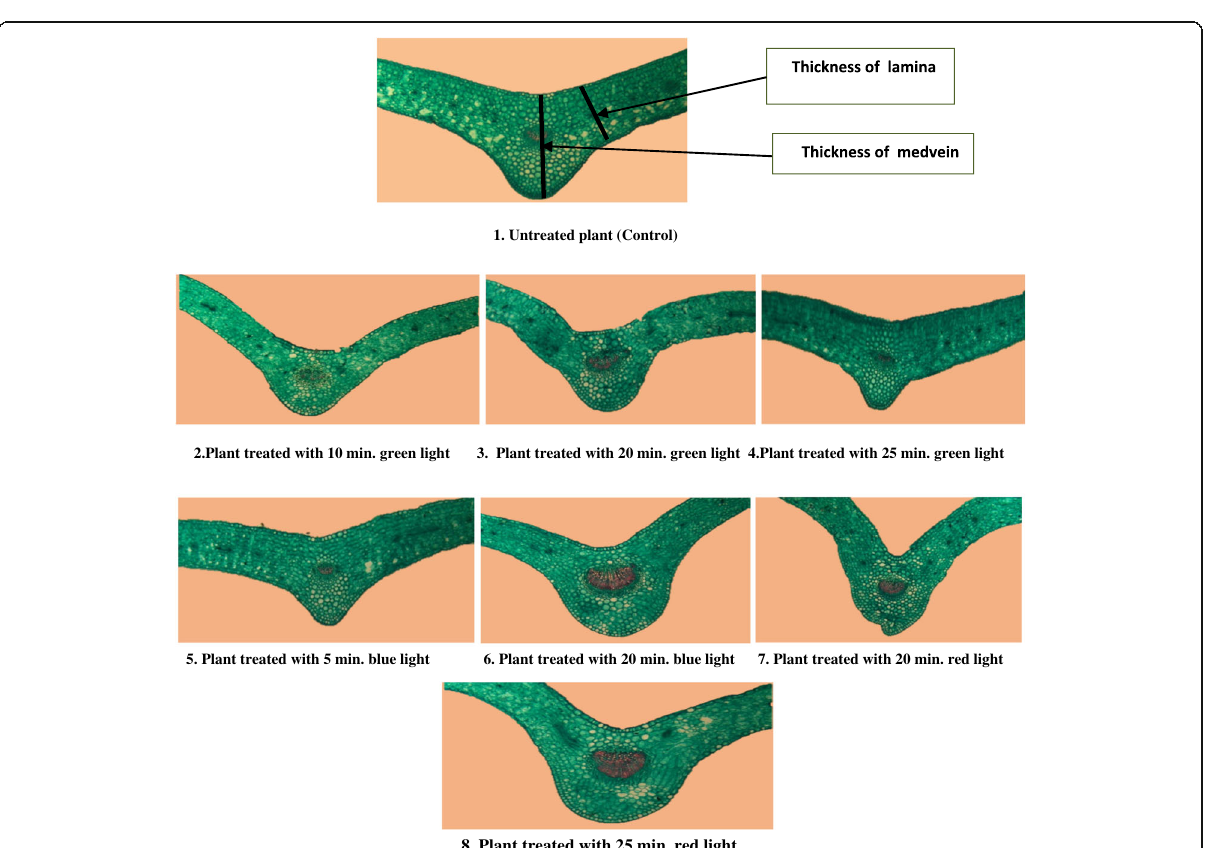
Fig. 6 Shows leaf anatomy of Eustoma grandiflorum under effect different types of laser radiation and time exposure. (1) Control, (2) 10 min green light, (3) 20 min green light, (4) 25 min green light, (5) 5 min blue light, (6) 20 min blue light, (7) 20 min red light, and (8) 25 min red light. Light microphotograph showing transverse sections through the blade of the third in vitro plant leaf developed on main stem of Eustoma grandiflorum plantlets (x10) (Bar = 0.05 ml). TM thickness of medvein, TL thickness of